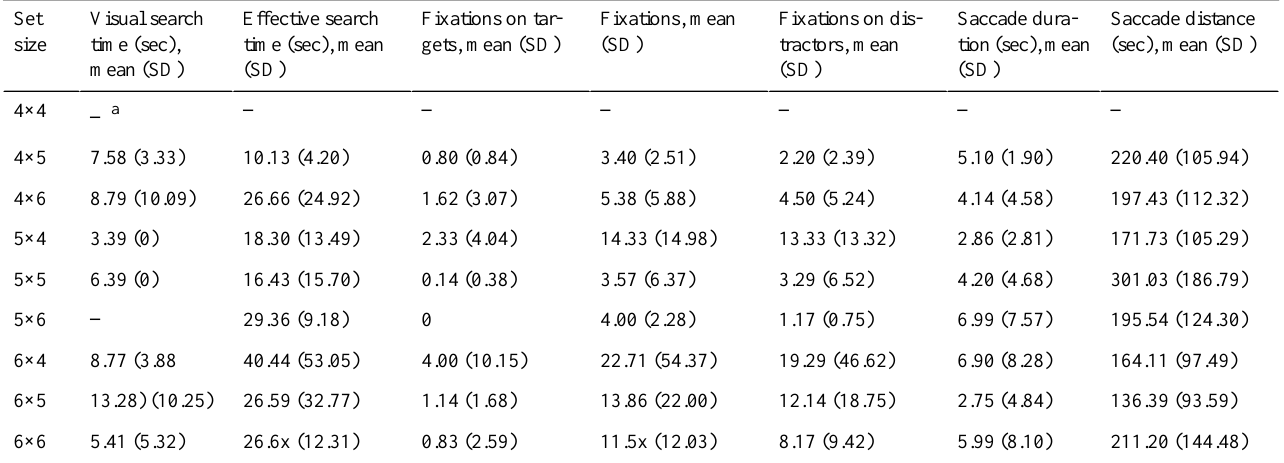
Table 3. Eye movement metrics for different board sizes.